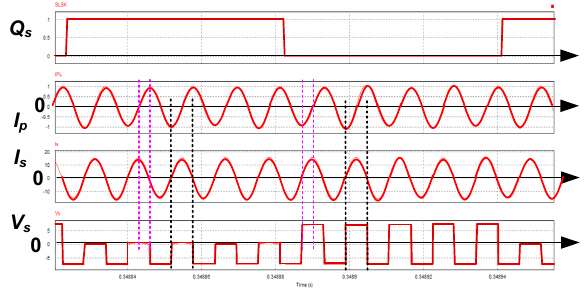
Figure 11. Phase differences in the Tx.